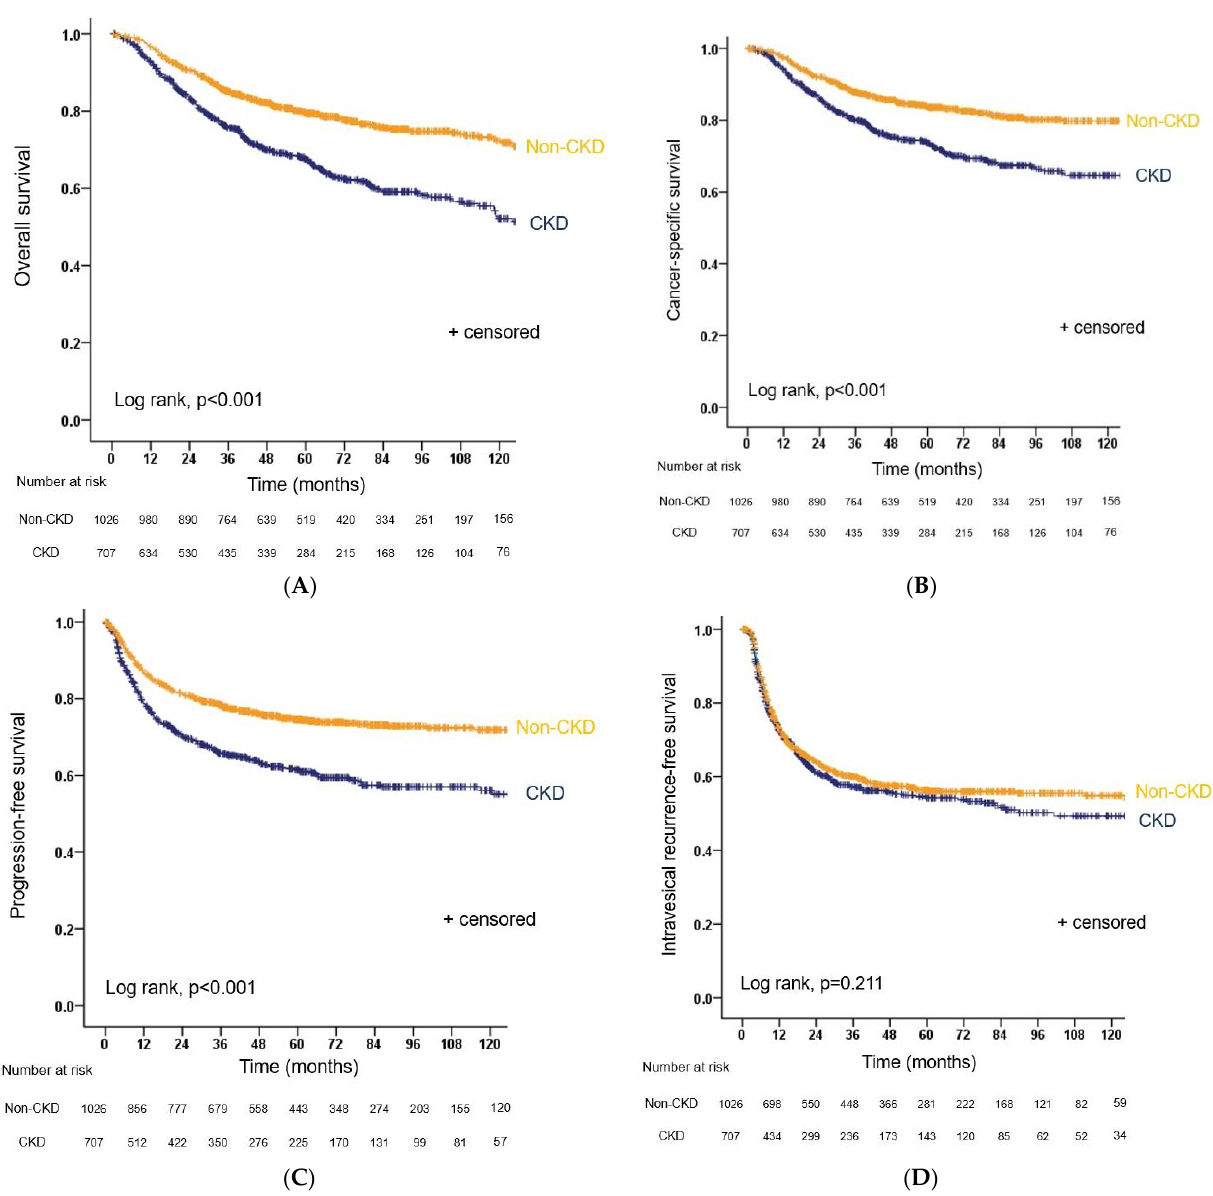
Figure 1. Kaplan – Meier analysis depicting: ( A ) overall survival; ( B ) cancer-specific survival; ( C ) progression-free survival; and ( D ) intravesical recurrence-free survival for patients with or without preoperative CKD. CKD, chronic kidney disease.